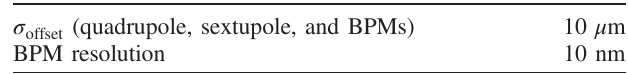
TABLE V. rms errors applied to the FFS lattice. σ (quadrupole, sextupole, and BPMs) offset